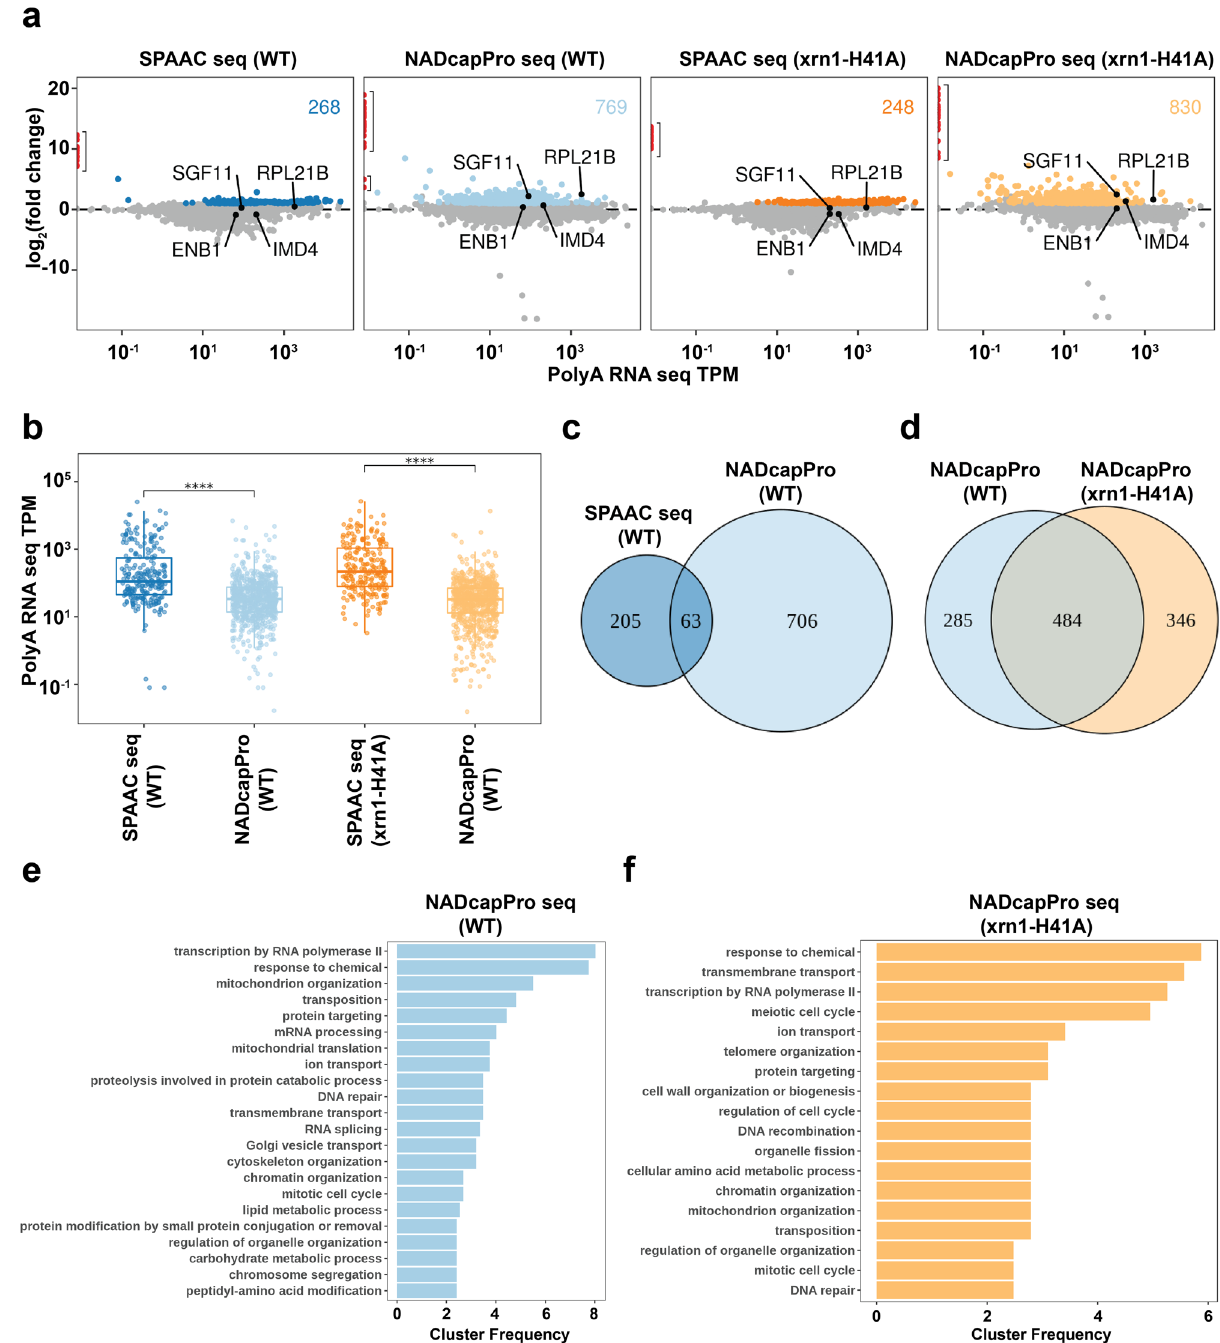
Fig. 3 NADcapPro Seq. a The relationship between RNA abundance and fold-change in the experimental condition is indicated at the top of each panel. The x-axis indicates RNA abundance from RNAseq derived from WT (blues) or xrn1 mutant (oranges) cells. The y-axis indicates the DESeq2 fold change. Colored points indicate a fold-change log 2 ≥ 1 and q-value ≤ 0.01. The number in the upper right indicates the number of genes meeting these criteria. b NADcapPro can capture low abundance transcripts. The distribution of average TPMs for the colored genes in ( a ) is shown. **** p < 0.0001 for a one- sided t-test testing if the NADcapPro distributions are less than the SPAAC distributions. Venn diagram overlap of the indicated gene sets in WT, NADcapPro and Xrn1-targeted NAD-RNAs are represented in ( c ) and ( d ) respectively. Gene ontology categories for the indicated gene sets in WT, NADcapPro ( e ) and Xrn1-targeted NAD-RNAs ( f ). All source data are contained in the GSE217259